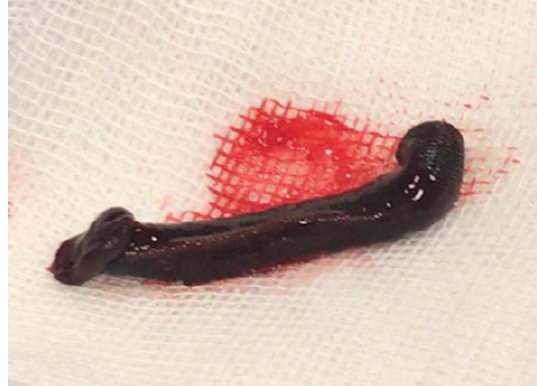
Figure 3. The removed